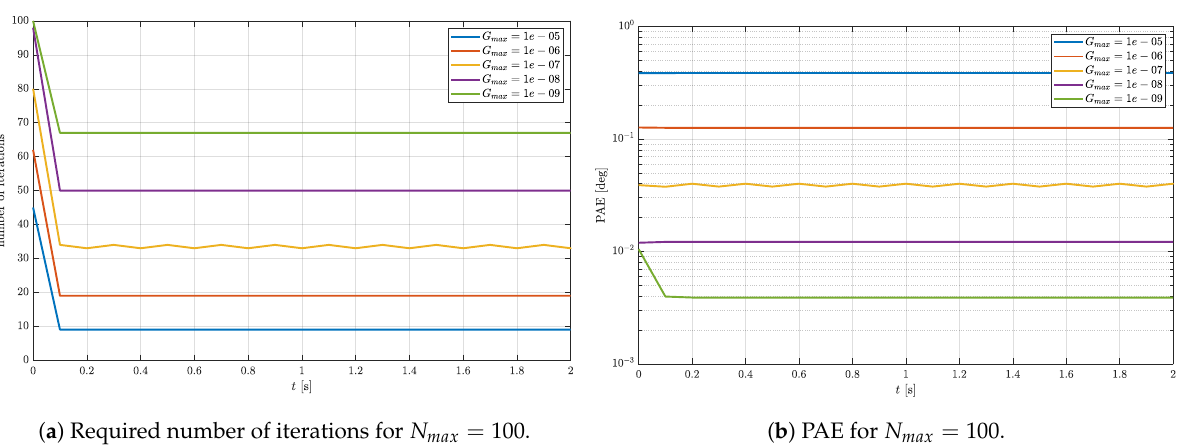
Figure 4. Required number of iterations and PAE of the estimated rotational quaternion µ =